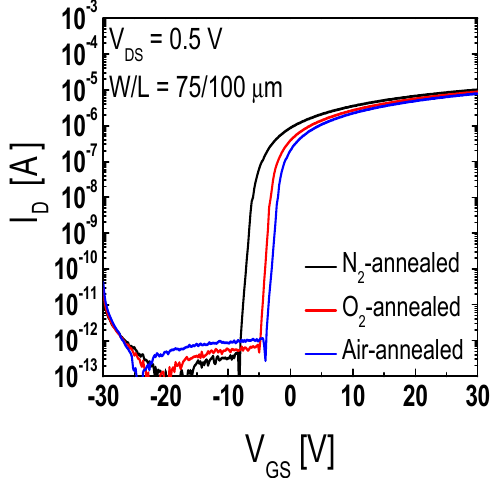
Figure 2. Transfer characteristics of N 2 -, O 2 -, and air-annealed IGTO TFTs plotted on a semi-logarithmic scale. The measurements were conducted by sweeping V GS from − 30 to 30 V at V DS = 0.5 V for all TFTs. Table 1. Electrical parameters of N 2 -, O 2 -, and air-annealed IGTO TFTs. Annealing